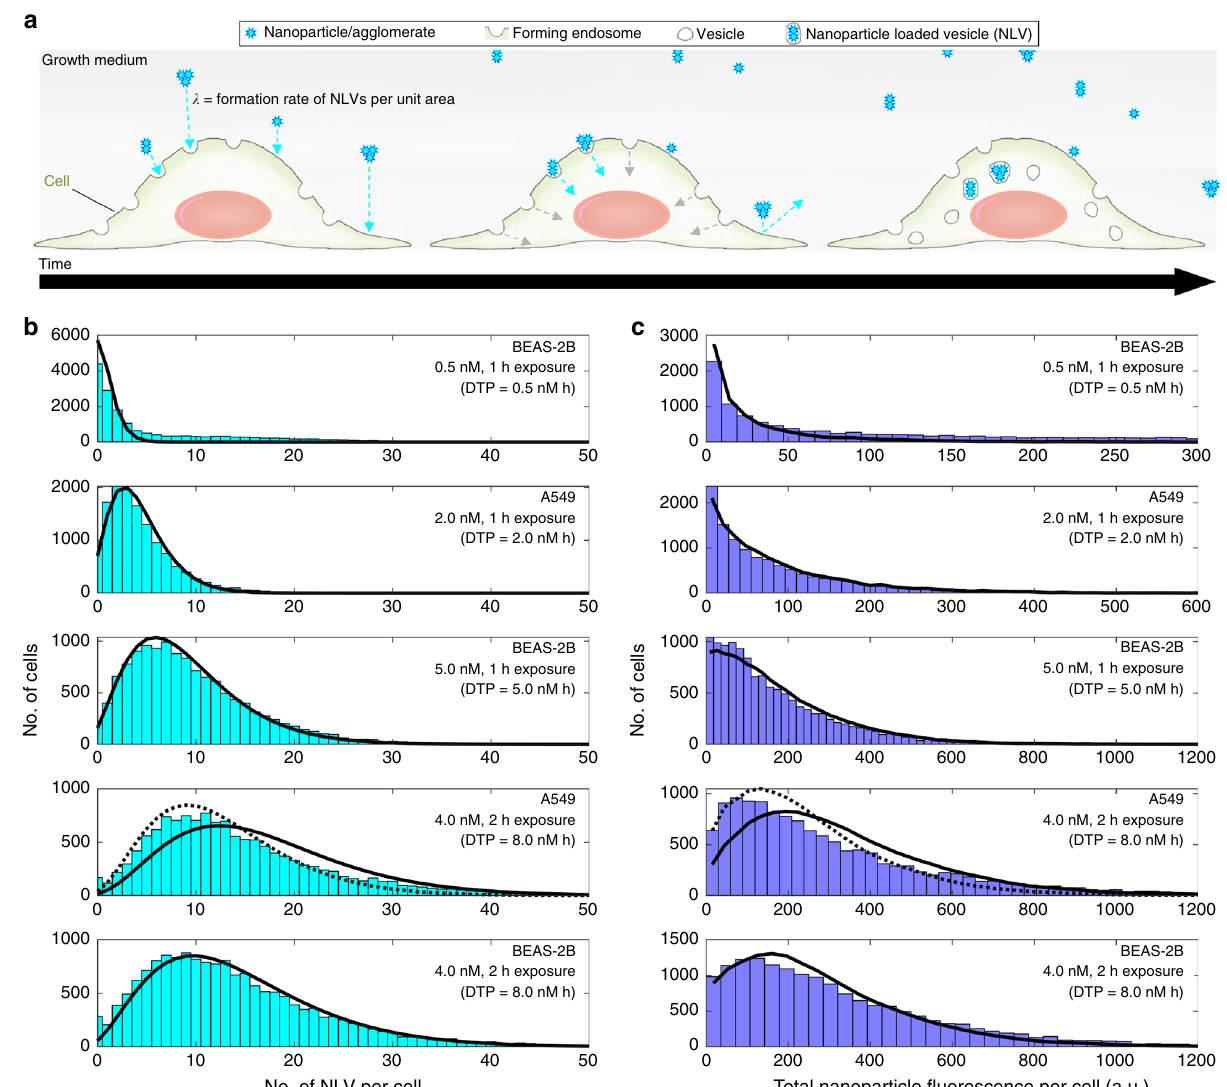
Total nanoparticle fluorescence per cell (a.u.) Fig. 3 Measurements and theoretical predictions of nanoparticle cellular delivery. a Schematic of nanoparticle uptake by endocytosis. Nanoparticle uptake is dependent on nanoparticles and/or agglomerates arriving at the site of a forming endosome. Given the timescales of particle arrival in the context of cell membrane turnover by endocytosis, it is highly improbable that a forming endosome will encounter more than one arrival event under physiologically relevant dosing conditions. In turn, the formation of more unloaded than nanoparticle-loaded vesicles (NLVs) can be expected. b Histograms showing the number of NLVs formed per cell across the cell population for both BEAS-2B and A549 cells under different exposure conditions (DTP = dose – time product). The black curves are the predicted NLV distributions (see Methods, Eq. 12) using the value of λ = 0.00107 nM − 1 h − 1 m − 2 for BEAS-2B cells and λ = 0.00135 nM − 1 h − 1 m − 2 for A549 cells. We note that the fi t to the 8.0 nM h data for the A549 cells is not as convincing as for the other experiments. However, the mean NLV count was lower than expected for this dose/exposure combination (see Fig. 2d), indicative of a slight error in dosing or exposure duration. If this is corrected for by using an expected value of 7.2 nM h provided by the straight line fi t to the data (indicated by arrow, Fig. 2d), the distribution shown by the dotted black line is obtained. c Histograms of total nanoparticle fl uorescence per cell across the cell population for the same exposure conditions as in b . The black curves are predicted cell intensity distributions (see Methods, Eq. 13). The underlying data are provided in